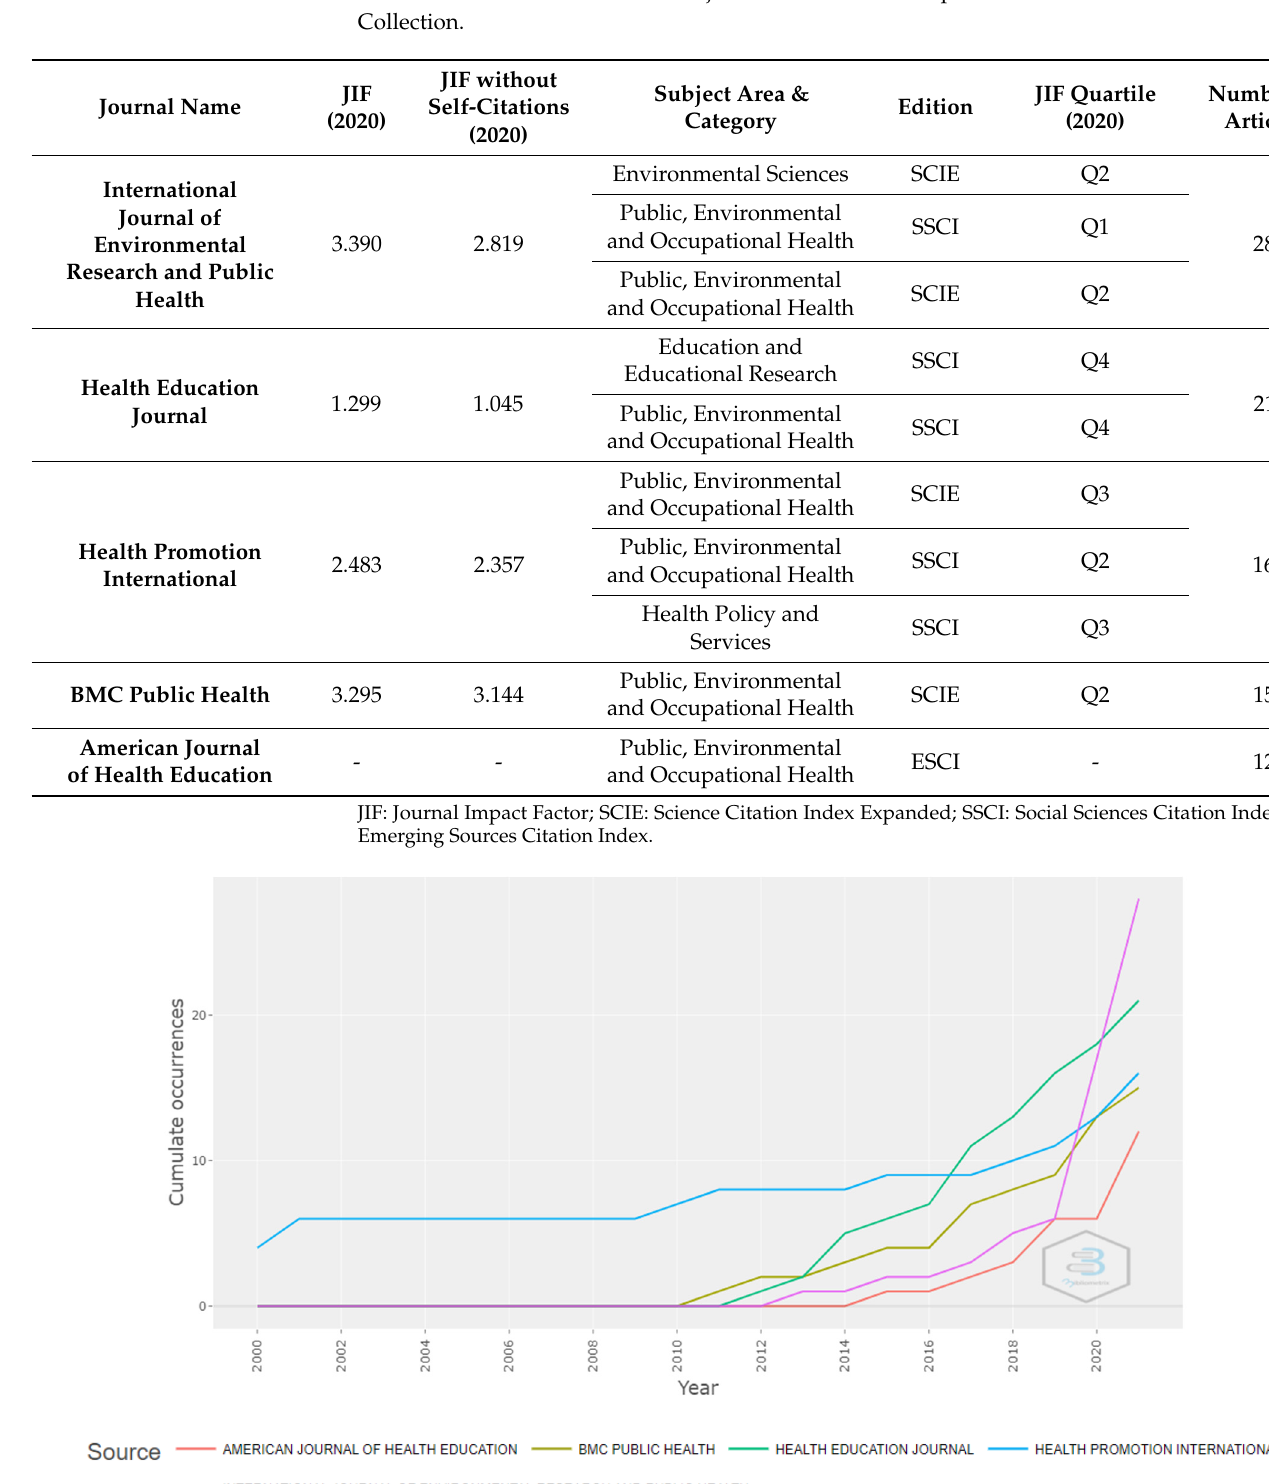
Figure 5. Source Figure 5. Source Growth.